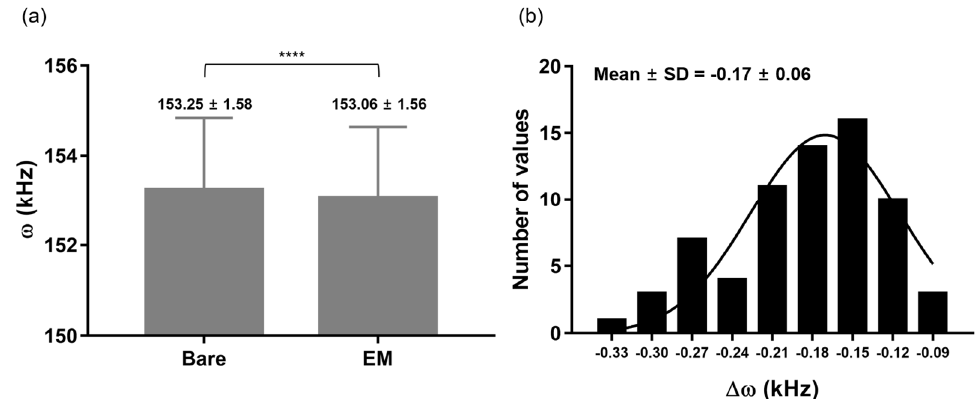
Figure 3. ( a ) ω before and after EM coating on the MC surface. ( b ) Histogram of Δ ω between bare MCs and EMMCs. **** p < 0.0001; ( n = 66) Abbreviation note: erythrocyte membrane (EM), and standard deviation (SD).